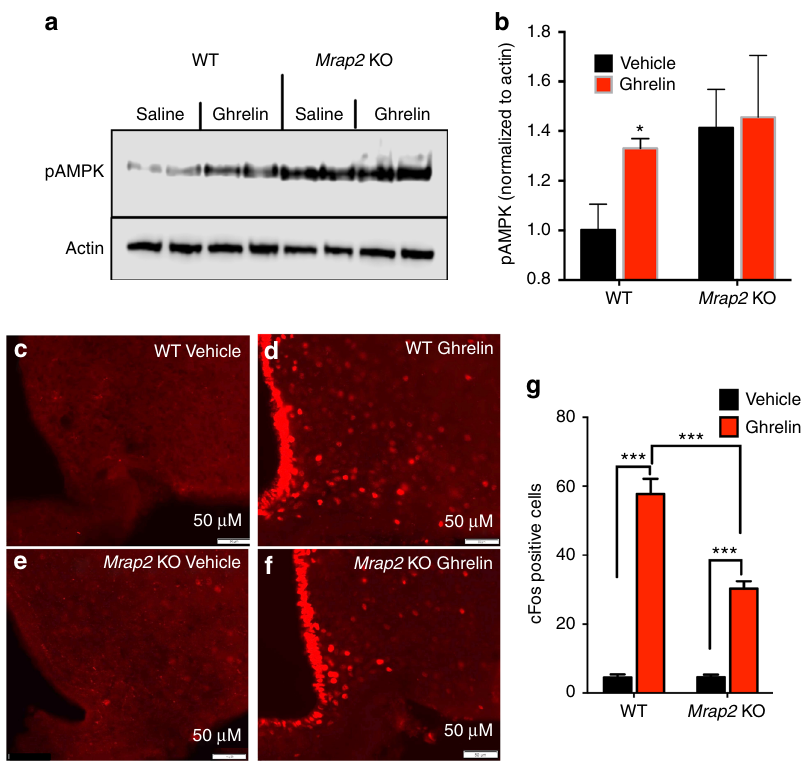
Fig. 5 MRAP2 potentiates the activity of the GHS-R1a in the hypothalamus. a , b Western blot ( a ) and densitometry analysis ( b ) of AMPK phosphorylation and actin expression (loading control) in the ARC of WT and Mrap2 KO mice injected IP with saline or ghrelin. n = 4/group. c – f Induction of cFos expression in ARC neurons of WT and Mrap2 KO mice by ICV injection of saline or ghrelin. cFos expression in ARC neurons was detected by immuno fl uorescence in WT ( c , d ) or Mrap2 KO ( e , f ) animals following ICV injection of saline or 13.5 μ g ghrelin. cFos induction in each condition was quanti fi ed and represented as mean ± SEM ( n = 5/group) ( g ). Error bars are SEM. * p < 0.05, *** p < 0.001